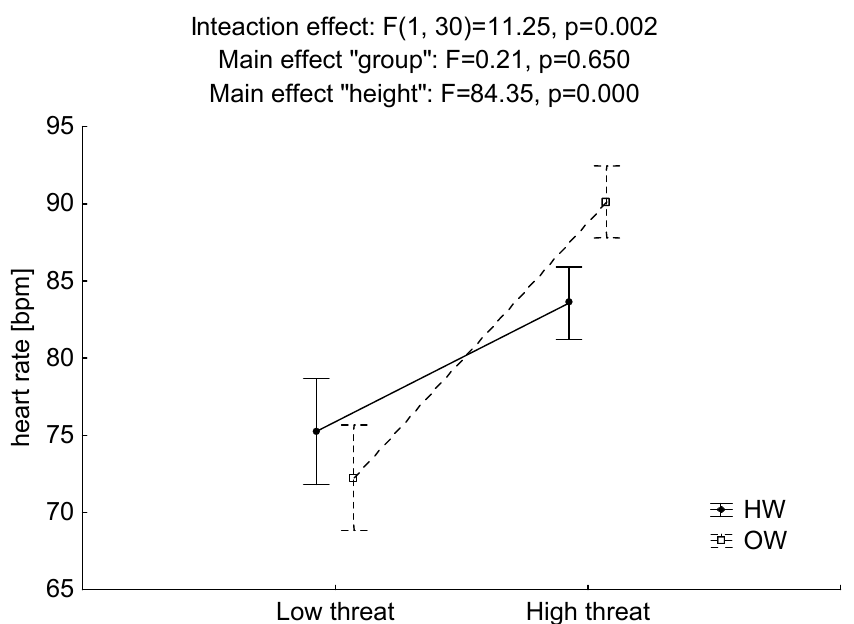
Figure 5. Mean values and standard error of measurements for cardiovascular stress at low and high postural threat in groups of at-height workers (HW) and office workers (OW).